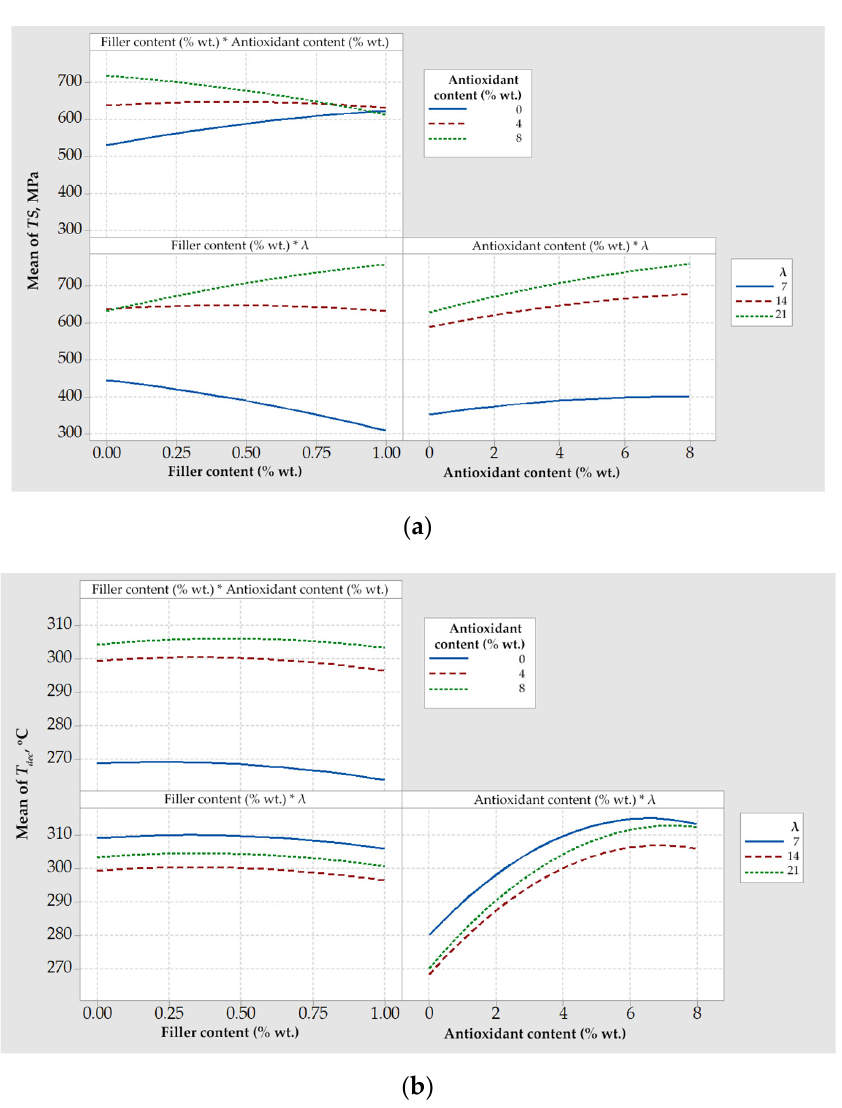
Figure 8. Interaction plots for ( a ) tensile strength, TS , and ( b ) onset decomposition temperature, T dec , regarding composites with SWCNTs.